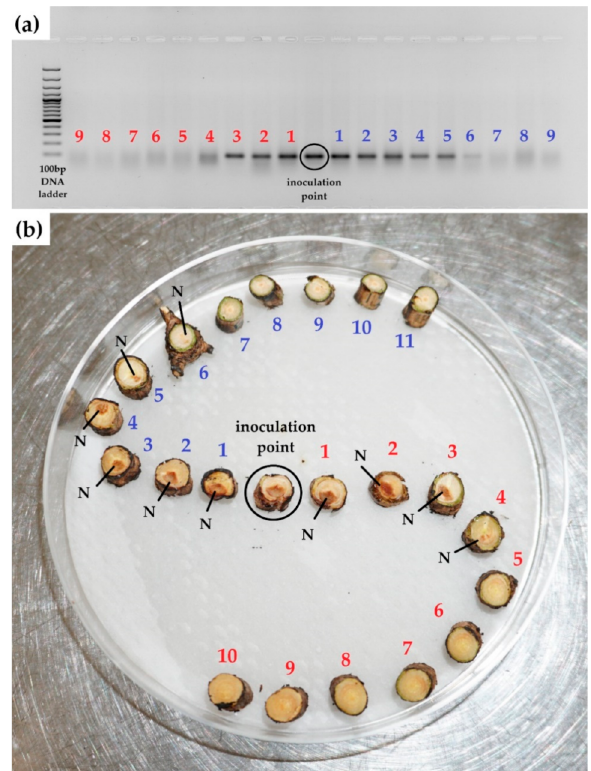
Figure 4. ( a ) PCR products from the control seedling; ( b ) cut stem disks from the same seedling. N—necrosis, circle—inoculation point, blue numbers—discs above inoculation point (sequential direction to the stem apex), red numbers—discs below inoculation point (sequential direction to the roots).